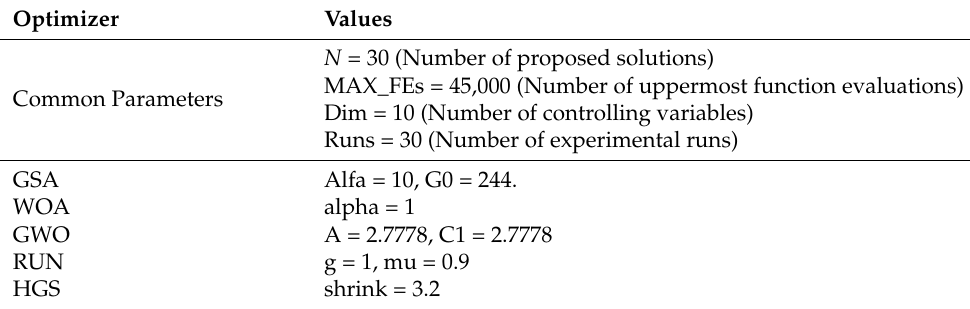
Table 2. Parameters’ values for the considered